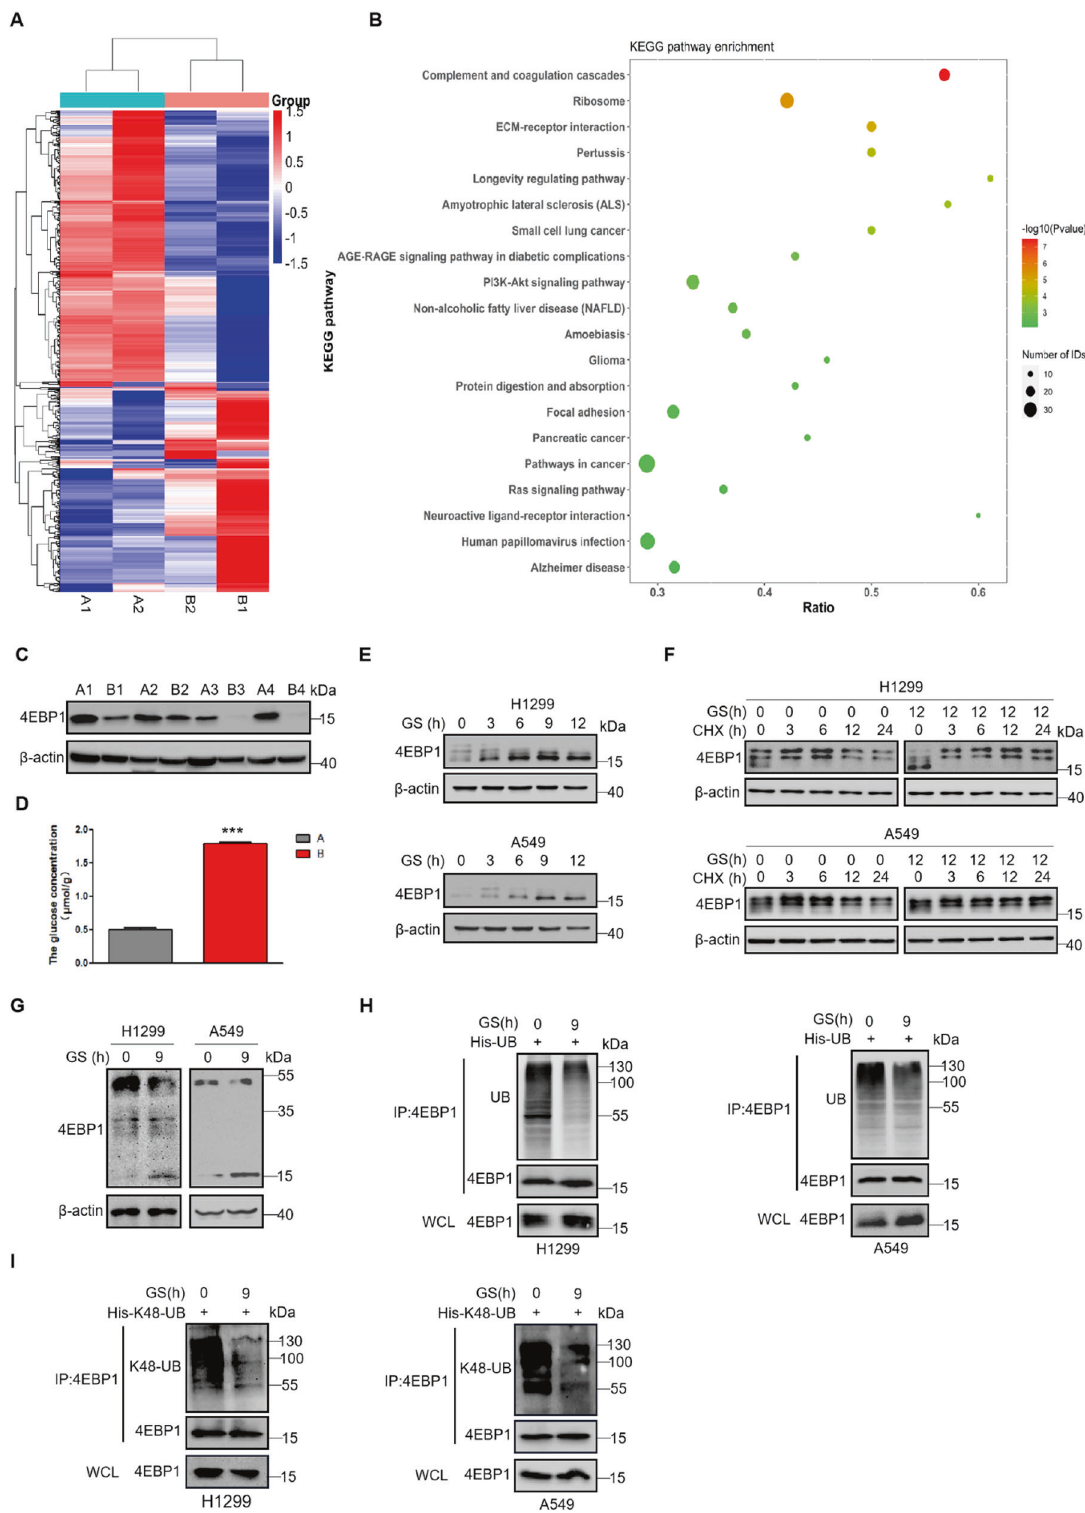
activation of STAT3, leading to decreased expression of anti- apoptotic genes and resulting in apoptosis. Taken together, these fi ndings elucidated a key role for 4EBP1 to regulate cell viability in response to glucose starvation conditions, which differed from its translational repression function. Cell Death and Disease (2022)